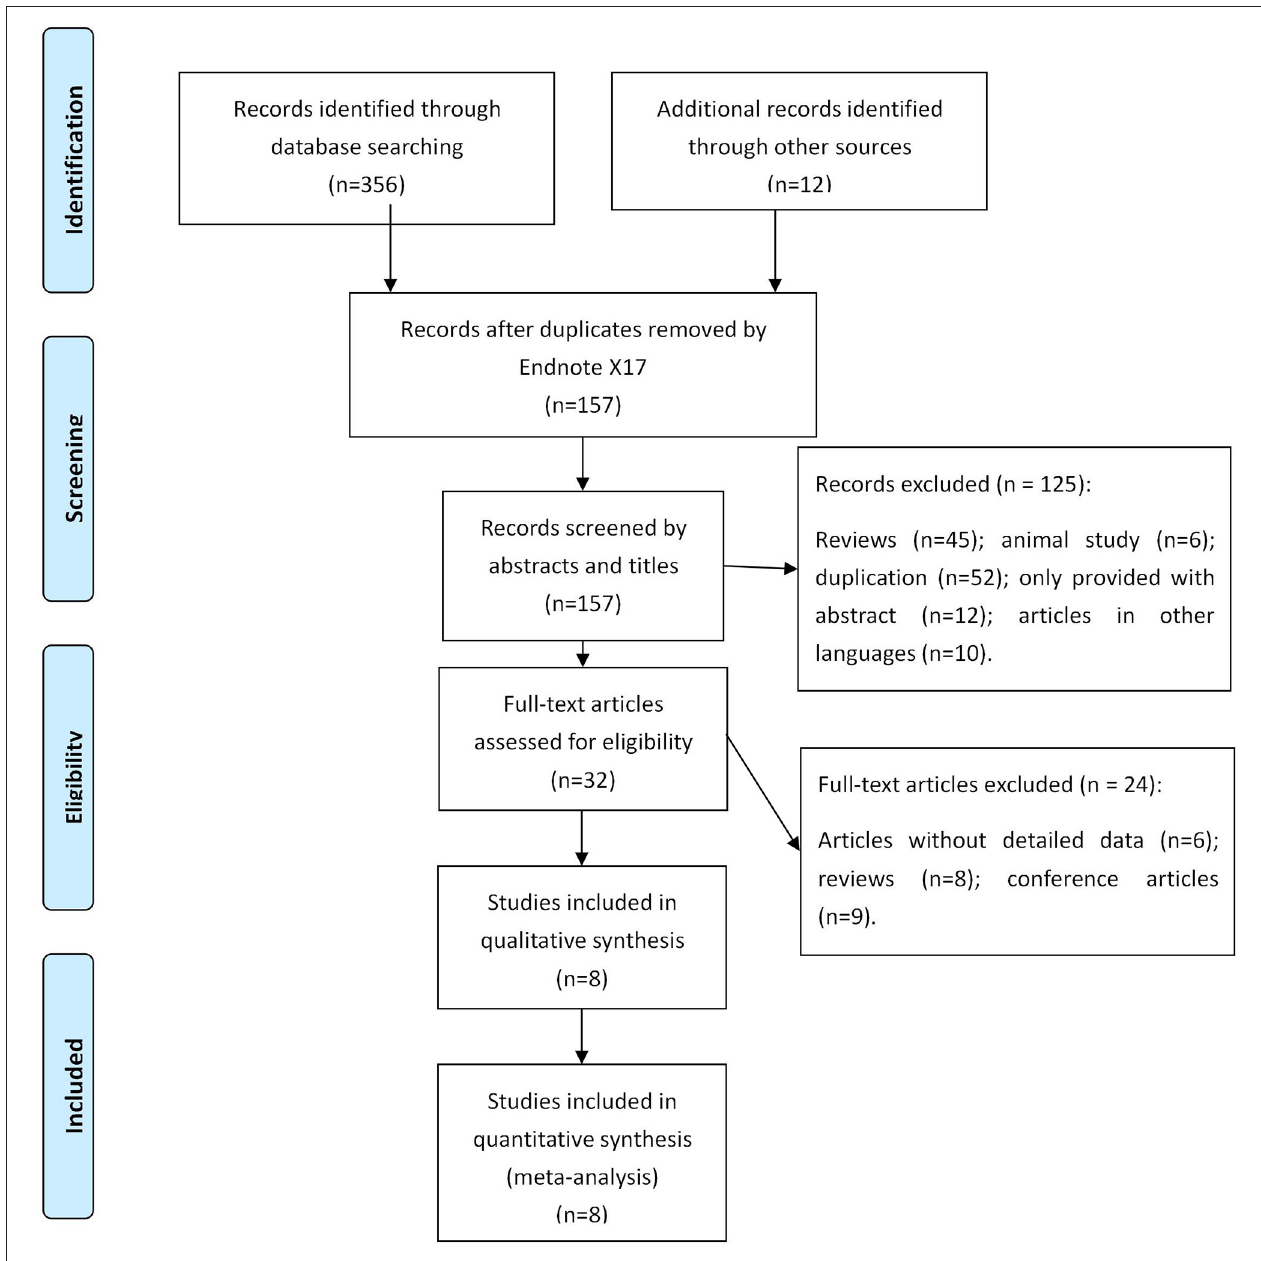
FIGURE 1 | Schematic of literature